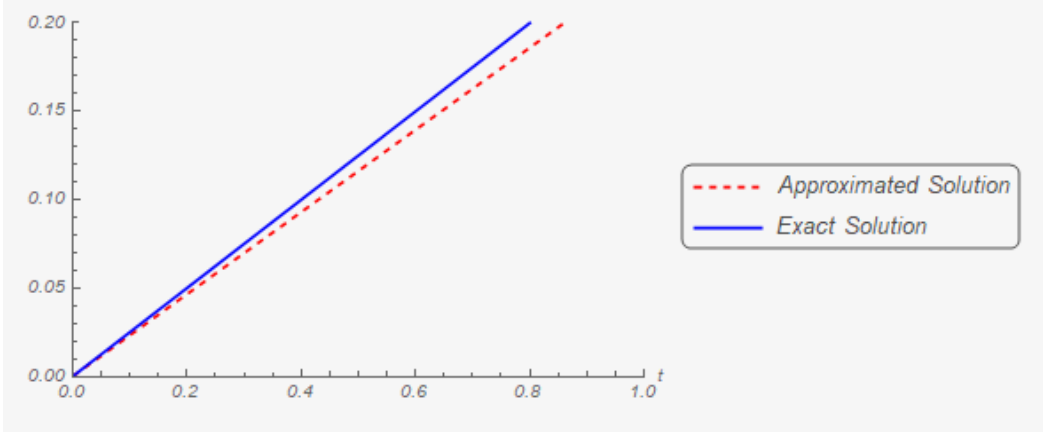
Figure 4. The second component of the exact solution and its fifth